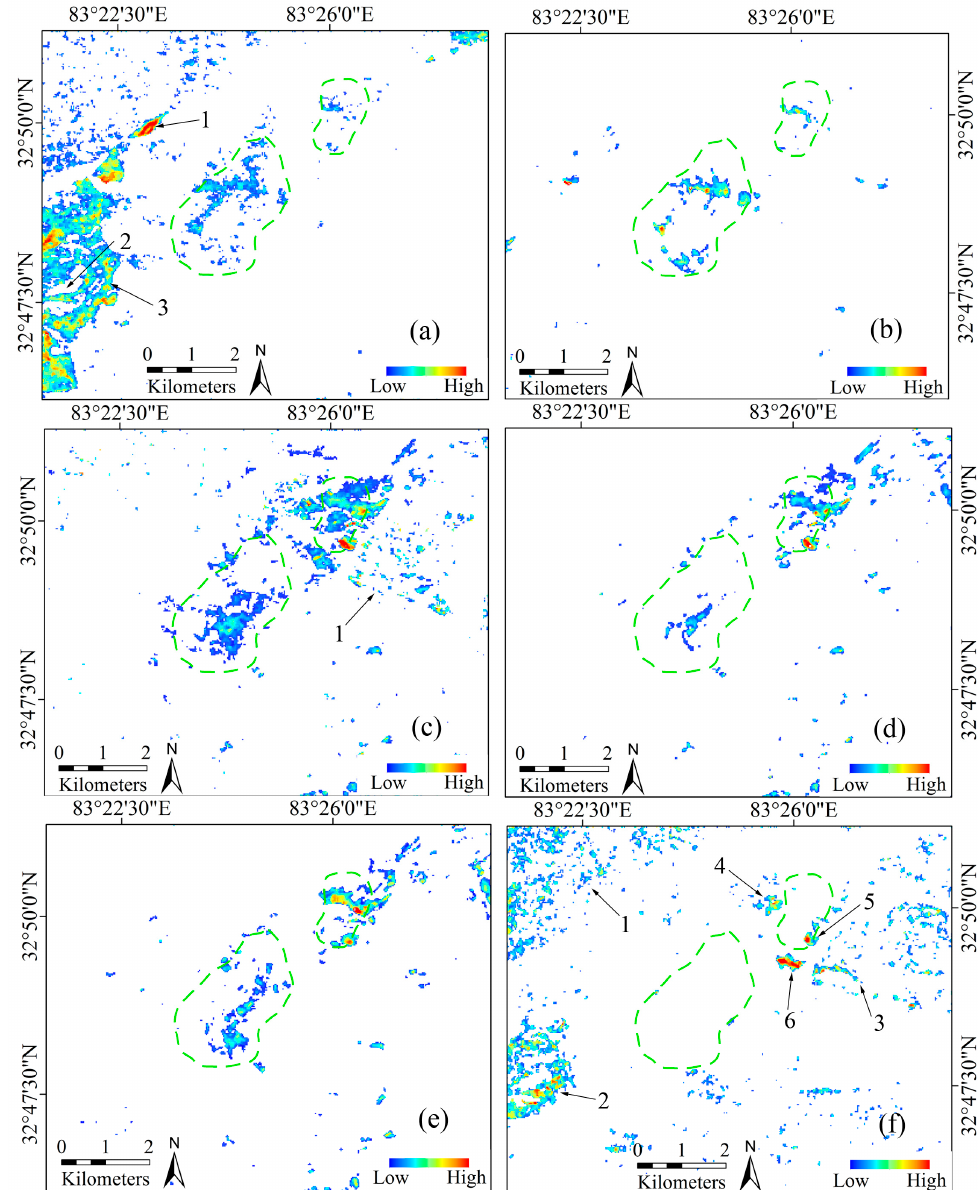
Figure 10. The abundance of ferric iron and ferrous iron group minerals of Duolong PCD. ( a ) FI 1 , ASTER RB B2/B1 (Threshold 90.8%); ( b ) FI 1 , AO RB B4/B1 (Threshold 98.5%); ( c ) FI 1 , ASTER RB B4/B3 (Threshold 95.5%); ( d ) FI 1 , AO RB B7/B6 (Threshold 97.8%); ( e ) FI 2 , AO VNIR bands MTMF (Infeasibility < 5); ( f ) FI 3 , ASTER RB B5/B4 (Threshold 94.9%). The green dotted line shows the altered zone outline from field investigations of Duolong PCD. The white areas indicate background values.